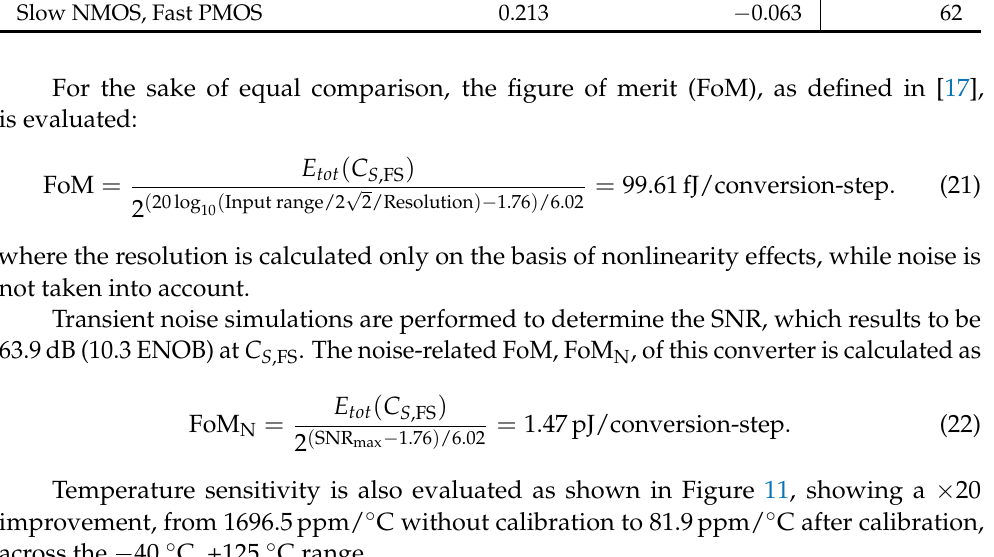
Table 1. Conversion-gain relative error (cid:101) k after calibration. Offset code, for C S = 0, is also reported. Nominal offset code is 63. Process Corner Uncalibrated (cid:101) corner Fast NMOS, Fast PMOS Fast NMOS, Slow